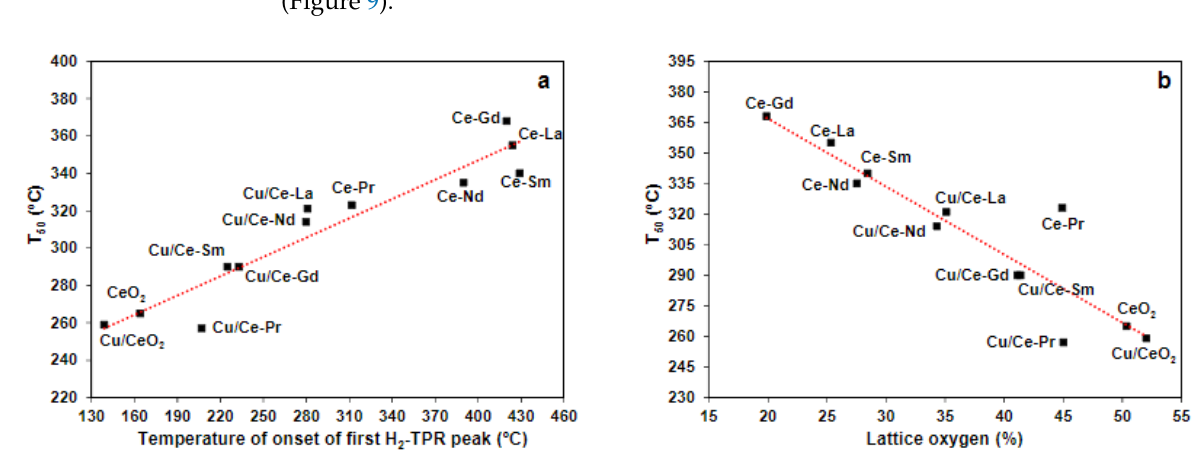
Figure 9. Correlation between the half-conversion temperature and ( a ) onset reduction temperature and ( b ) the lattice oxygen capacity for various ceria-based catalysts in ethyl acetate oxidation; Catalysts designation: Ce 0.5 Gd 0.5 O 1.75 (Ce-Gd), Ce 0.5 La 0.5 O 1.75 (Ce-La), Ce 0.5 Pr 0.5 O 1.75 (Ce-Pr), Ce 0.5 Nd 0.5 O 1.75 (Ce-Nd) and Ce 0.5 Sm 0.5 O 1.75 (Ce-Sm). Reproduced from Ref. [90]. Copyright© 2016, MDPI.